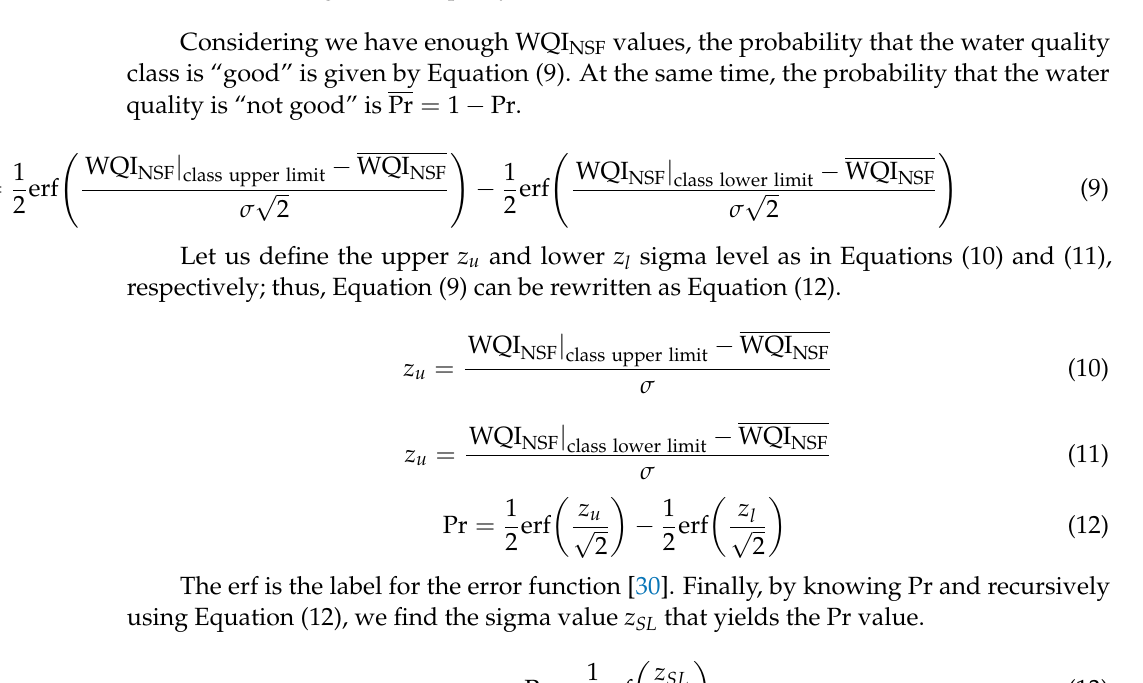
Figure 6. The distribution function of a set of WQI NSF values with a mean of 75. The threshold values from Table 3 define good water